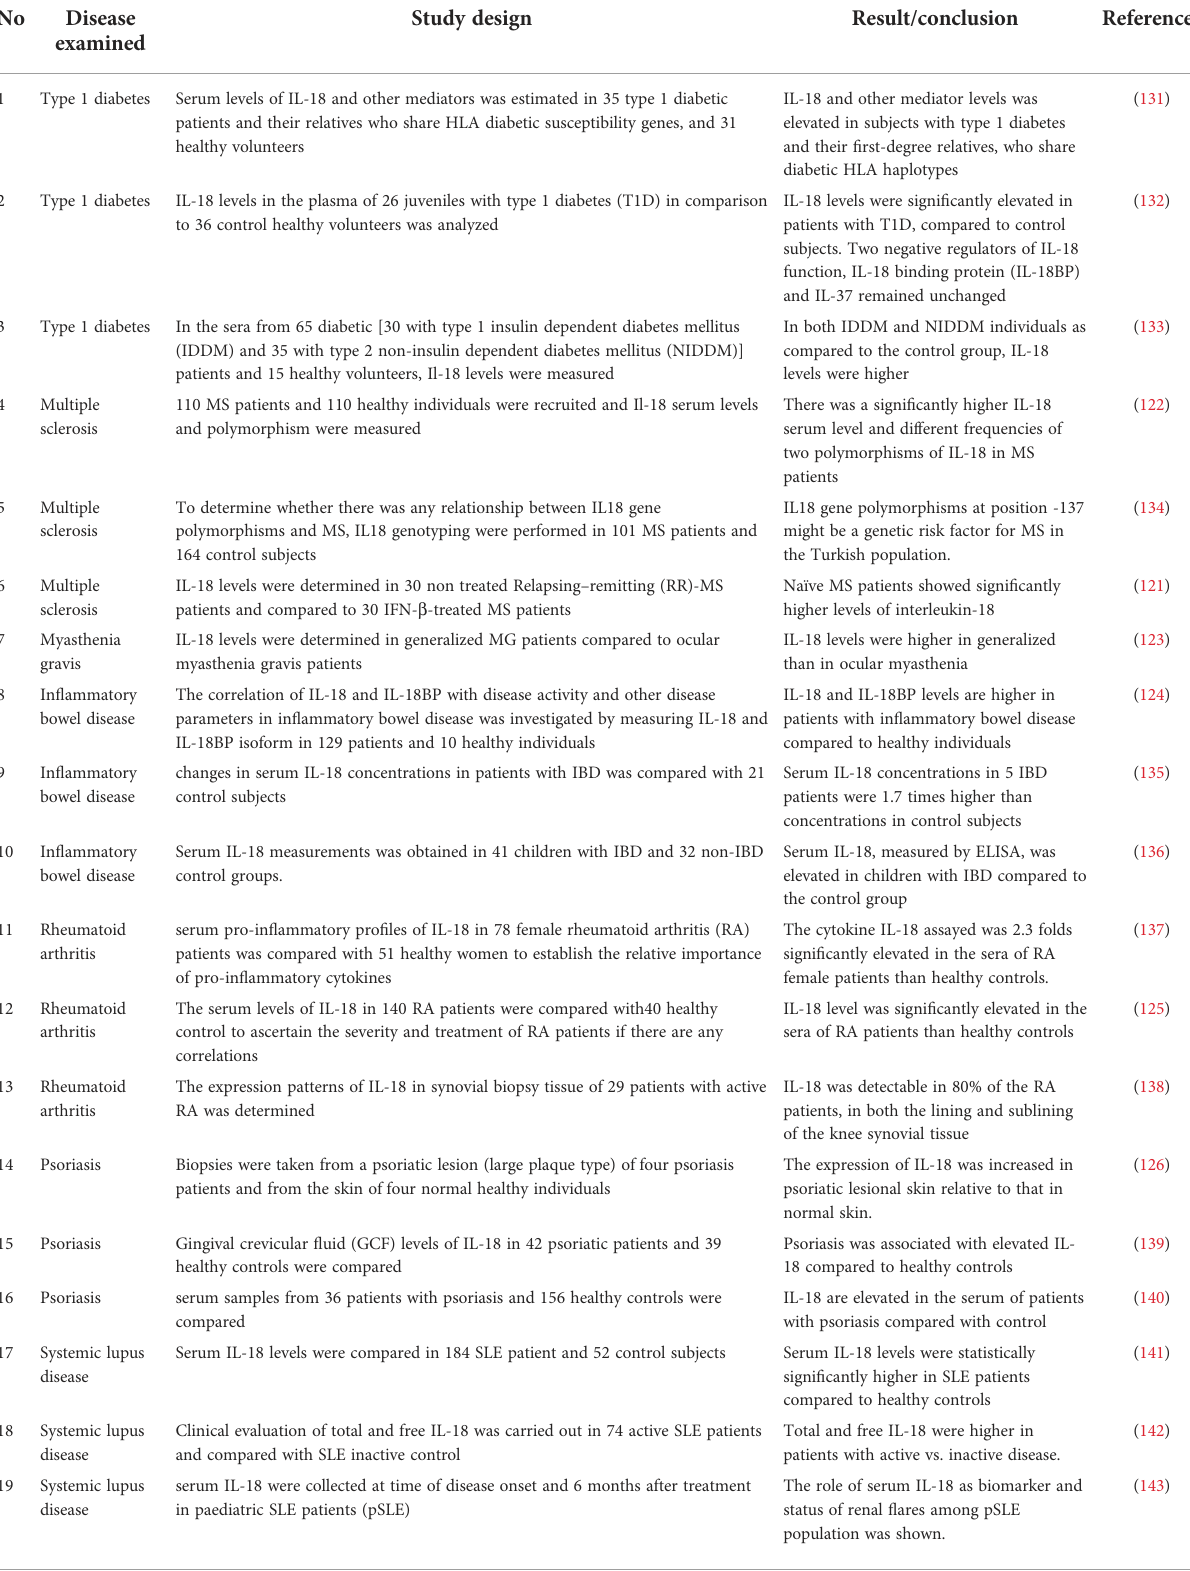
TABLE 2 Clinical studies showing the pathogenic role of IL-18 in in fl ammatory diseases. .